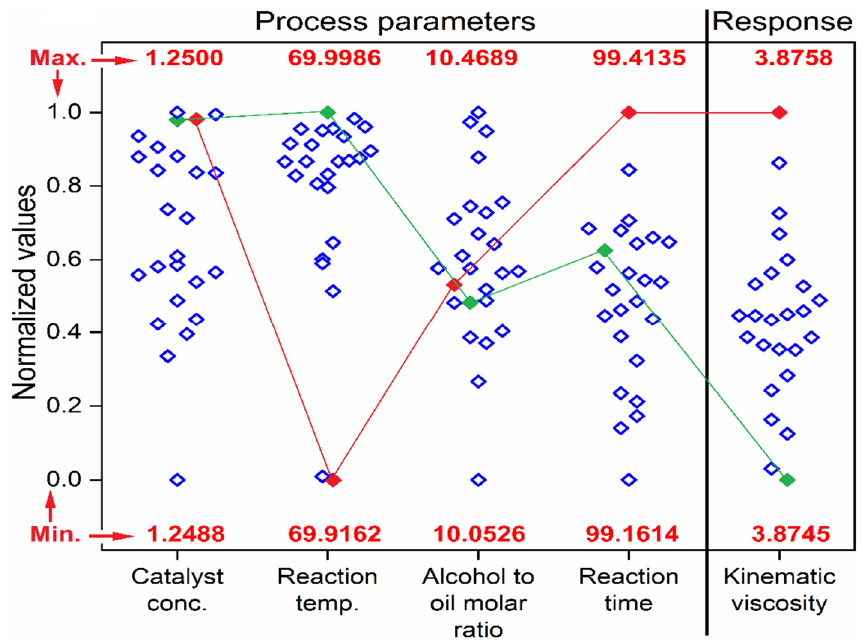
Figure 10. Optimum process parameters and response reported in 25 independent trials of GWO. Green data points and line indicate the best results among the 25 independent trials. Red data points and line indicate the worst results among the 25 independent trials.